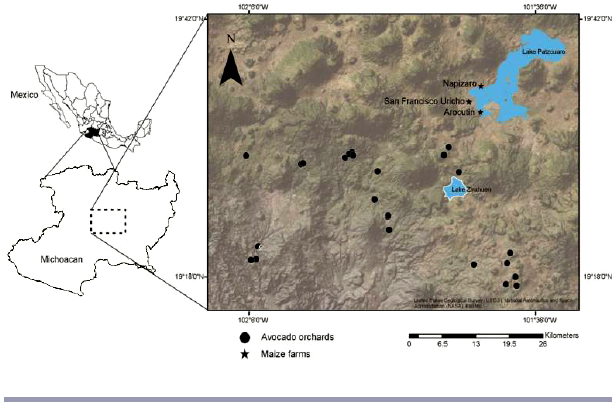
Fig. 1. Location of the study cases in Michoacán, central